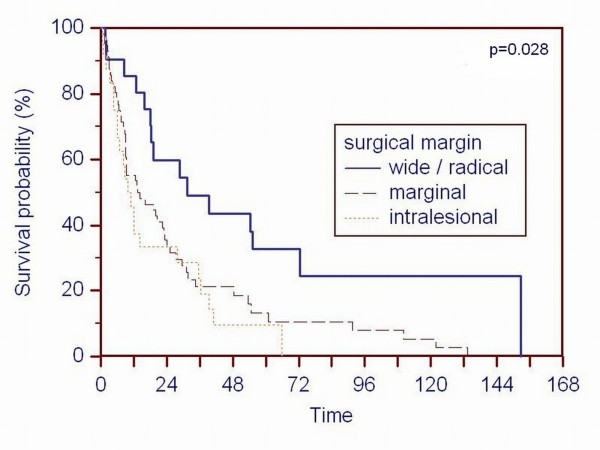
A Kaplan-Meier survival curve of patients based on the surgical margin according to the Enneking classification [16]shows that patients with a tumor-free resection margin have a better survival rat (p = 0.028) than patients with a tumor-infiltrated resection margin.